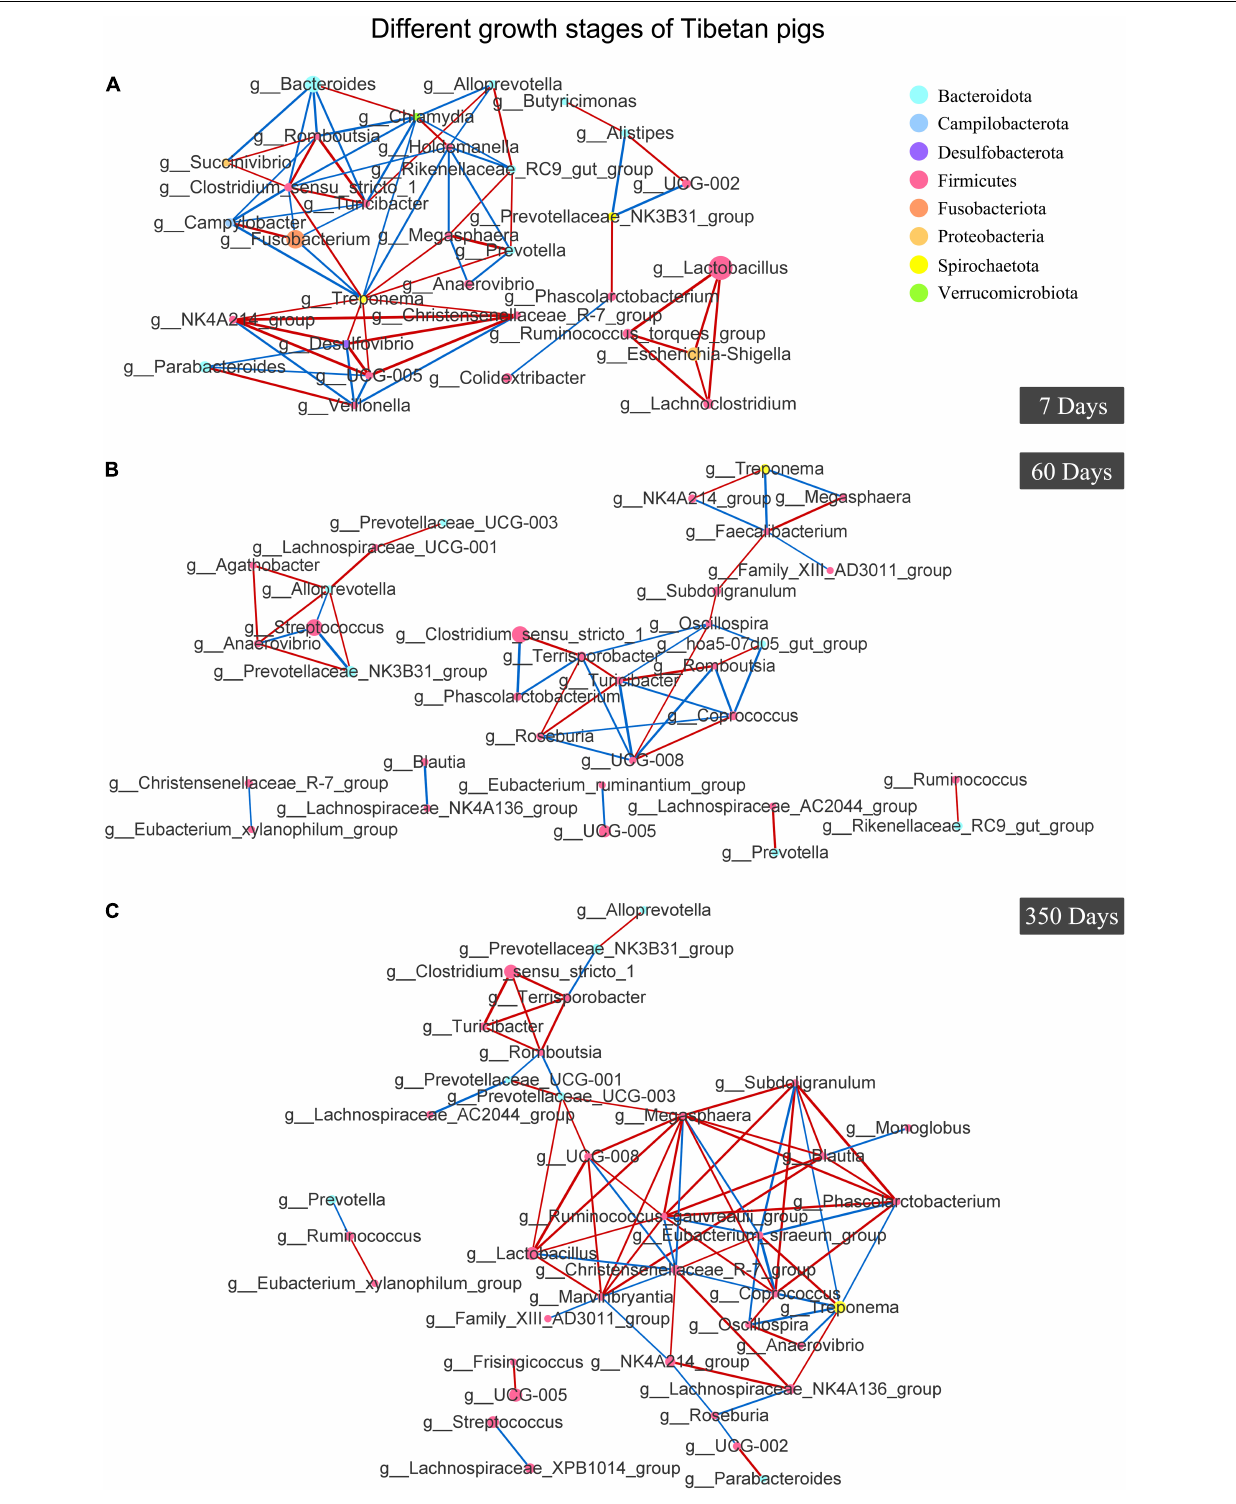
FIGURE 7 | Analysis of Co-occurrence Network of gut bacteria in Tibetan pigs at different growth stages. Co-occurrence Network of Tibetan pigs at day 7 (A) , day 60 (B) , and day 350 (C) . Individual color of dots represented the phyla in the gut. The size of nodes was proportional to the relative abundance of genus. Red lines stood for positive correlations between species, and blue lines represented negative correlations between species. The thickness of the lines indicated the size of the correlation coefficient value.